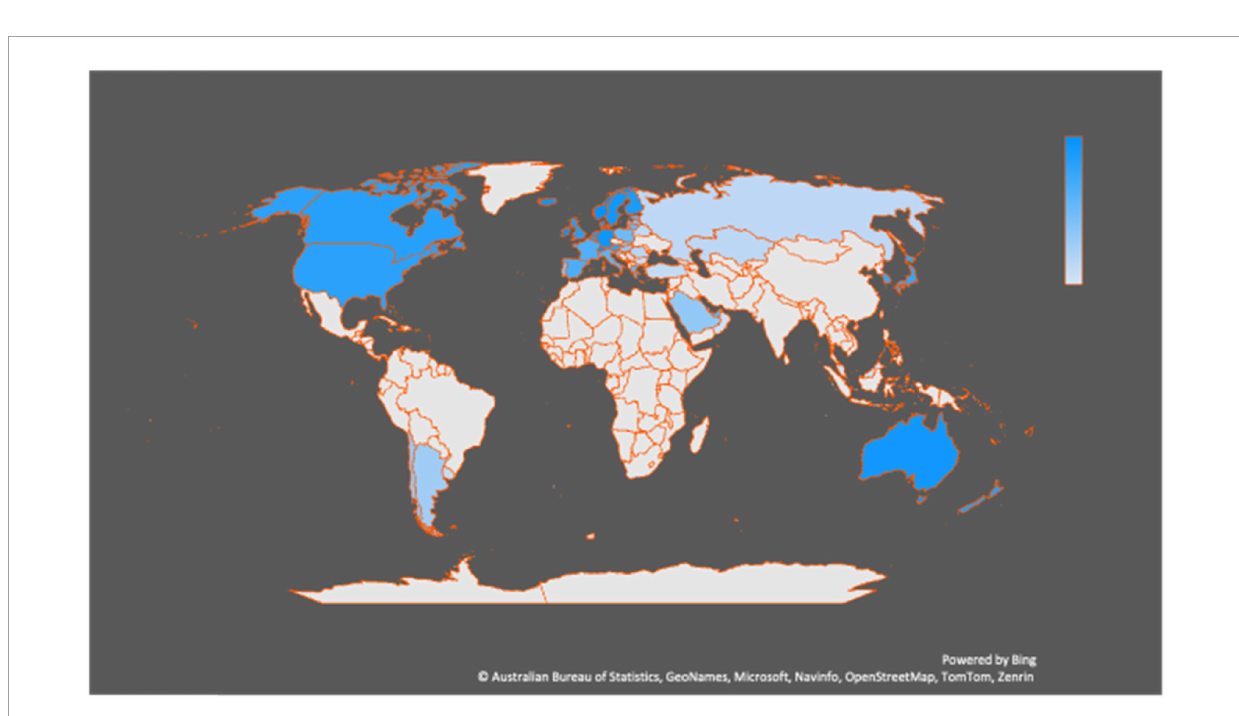
FIGURE8 Global distribution of the Human Development Index (HDI), as of 2022. As expected, the HDI is stronger for developed